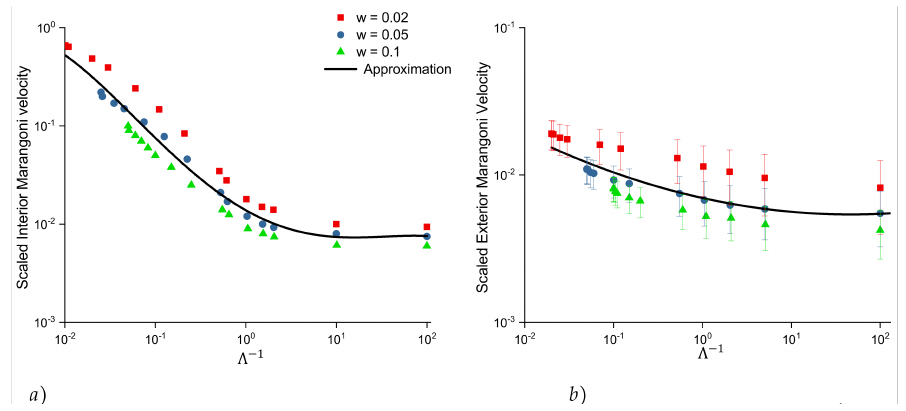
Figure 9. Dimensionless Marangoni velocities for different film thicknesses and Bo number ( Λ − 1 ) for ( a ) interior ( b ) exterior foams. The velocity values for the different film thicknesses are represented by symbols, and the approximation (fitted line) is represented by the solid curve. In the exterior of the foam ( b ), the simulated data points with different thickness have quite different Λ − 1 , and the fitted line is estimated for all simulated data points. Therefore, it is possible to observe some deviations from the fitted line for some of the data points, particularly for those with different thickness. Therefore, to accurately reflect the uncertainties in the data, error bars have been